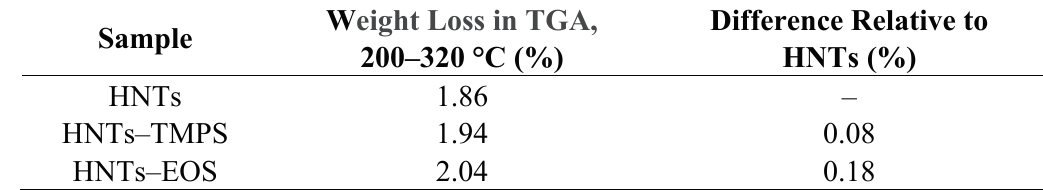
Table 3. Weight loss by thermogravimetrical analysis (TGA) of HNTs and functionalized